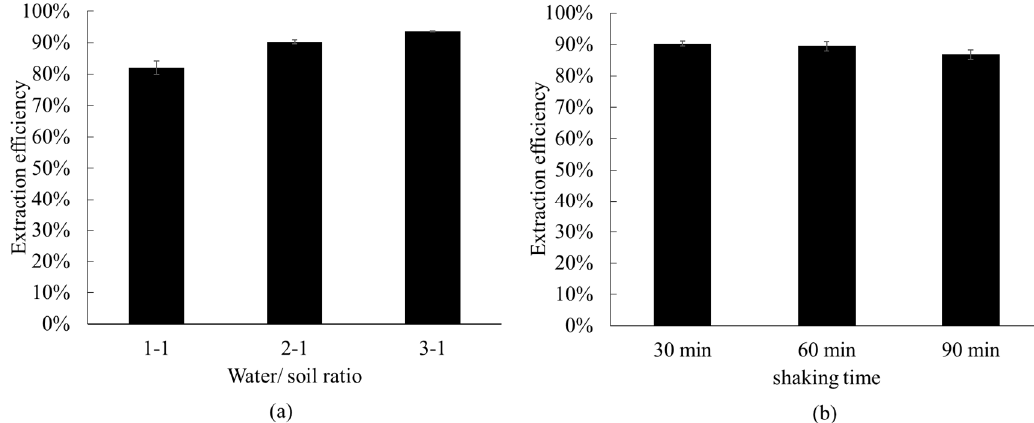
Figure 2. Sulfolane removal by soil washing; ( a ) different water/soil ratios with 30 min shaking; ( b ) different shaking periods with water/soil ratio = 2:1. The error bars represent the variation of duplicates.